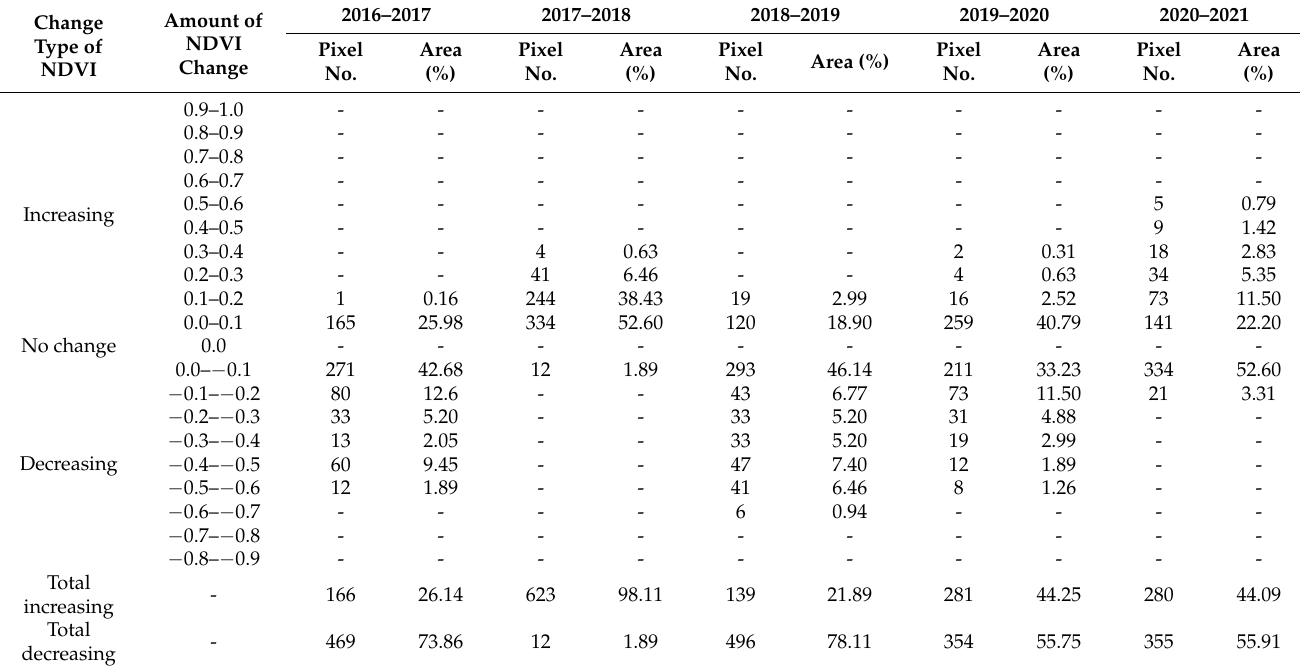
Table 3. The results of change detection NDVI for the month of July, 2016–2021.